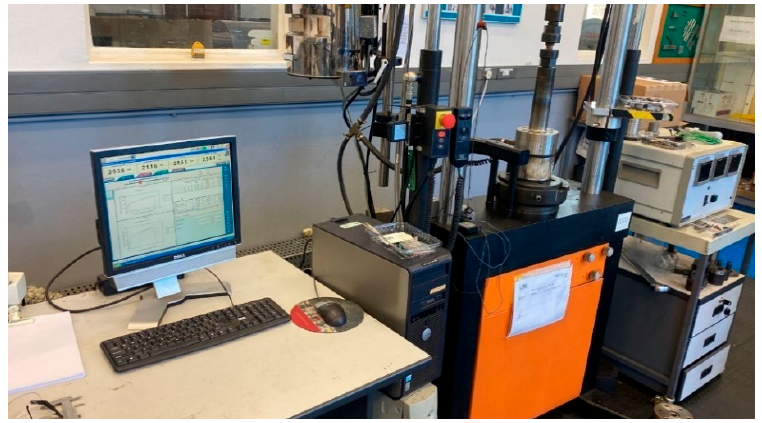
Figure 3. The Instron 1342 servo-hydraulic universal test machine (UTM) at CSIR.